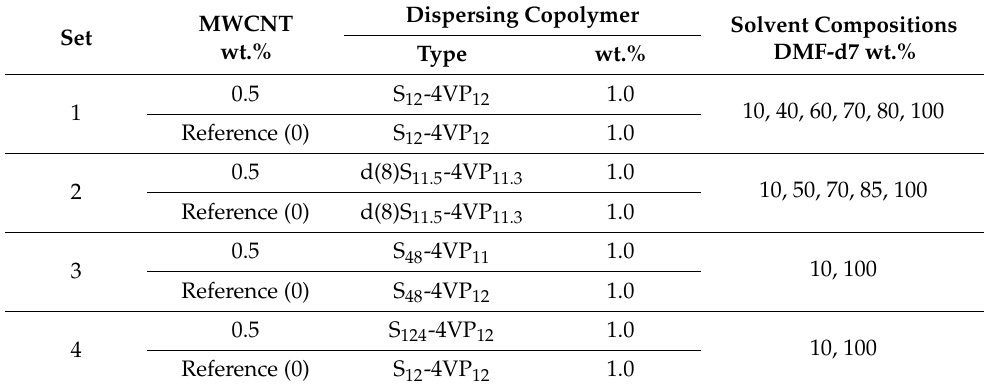
Table 3. Characteristics of the prepared sample